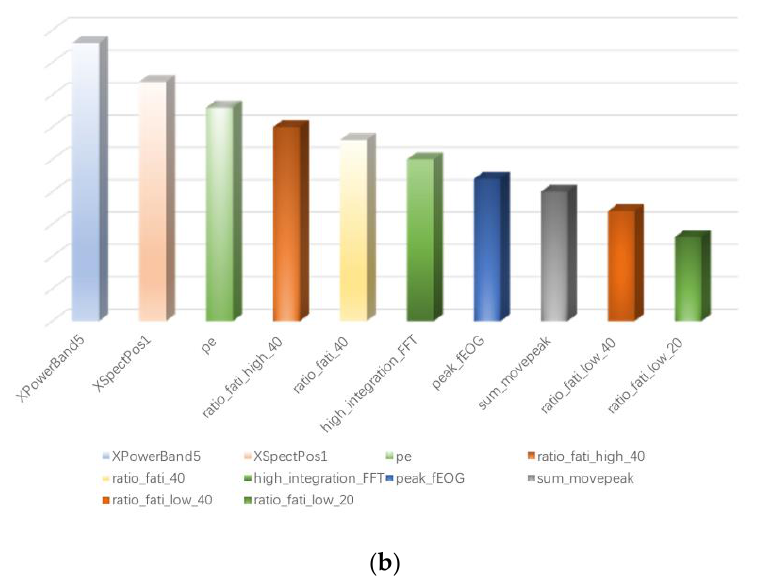
Figure 8. ( a ) The extracted features as a directed graphical. ( b ) Correlation ranking of all features.